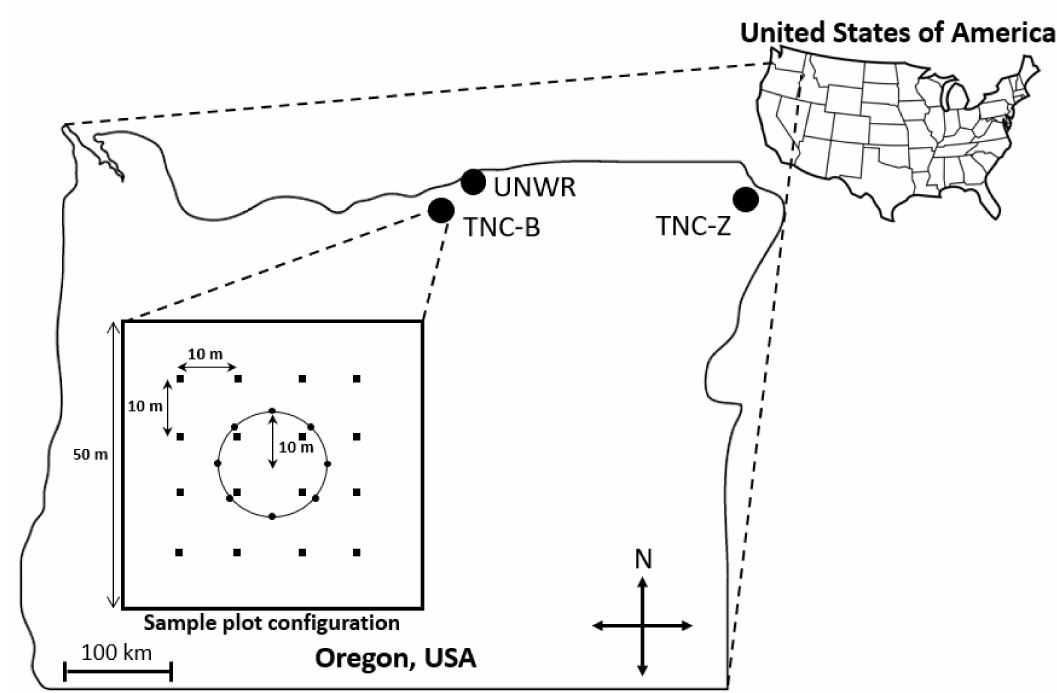
Figure 1. Map of the three study locations (TNC-B, TNZ-Z, and UNWR) in northeastern Oregon, USA with inset showing sample 50 m plot survey configuration. Circles represent pitfall traps; squares represent habitat survey